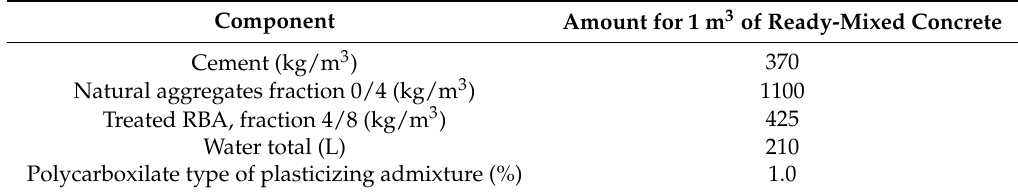
Table 2. Composition of concrete mixtures based on treated RBA.